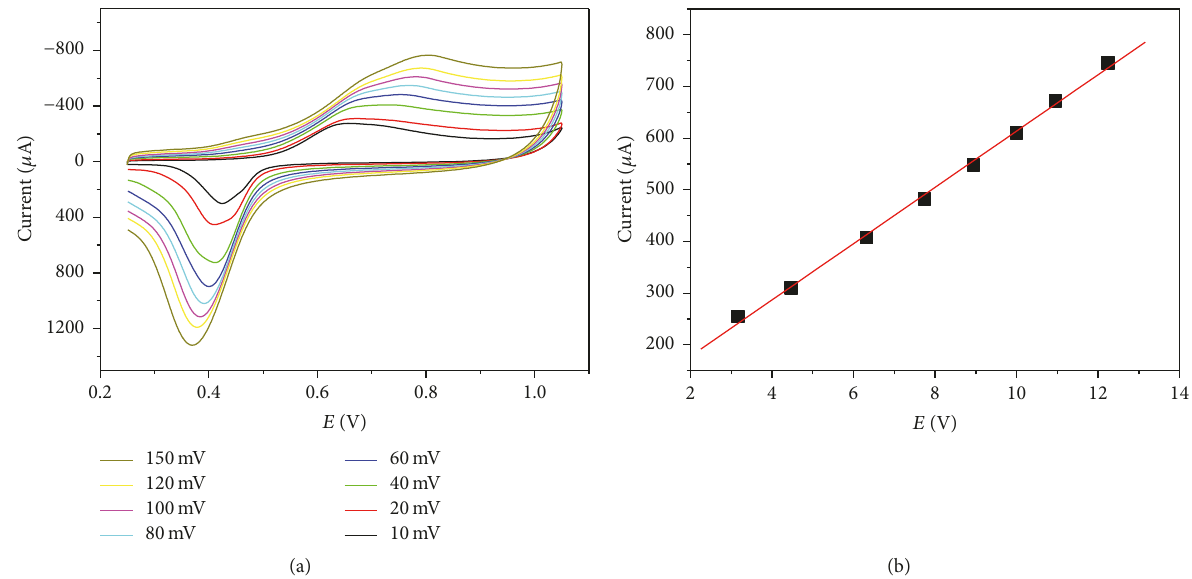
Figure 8: (a) CVs of the C/Co 2 P/Pd/GCE in 5 mM formaldehyde of 0.5 M H 2 SO 4 solution with different scan rates (10, 20, 40, 60, 80, 100, 120, and 150 mV/s). (b) The relation of the oxidation current of formaldehyde with square root of scan rate.